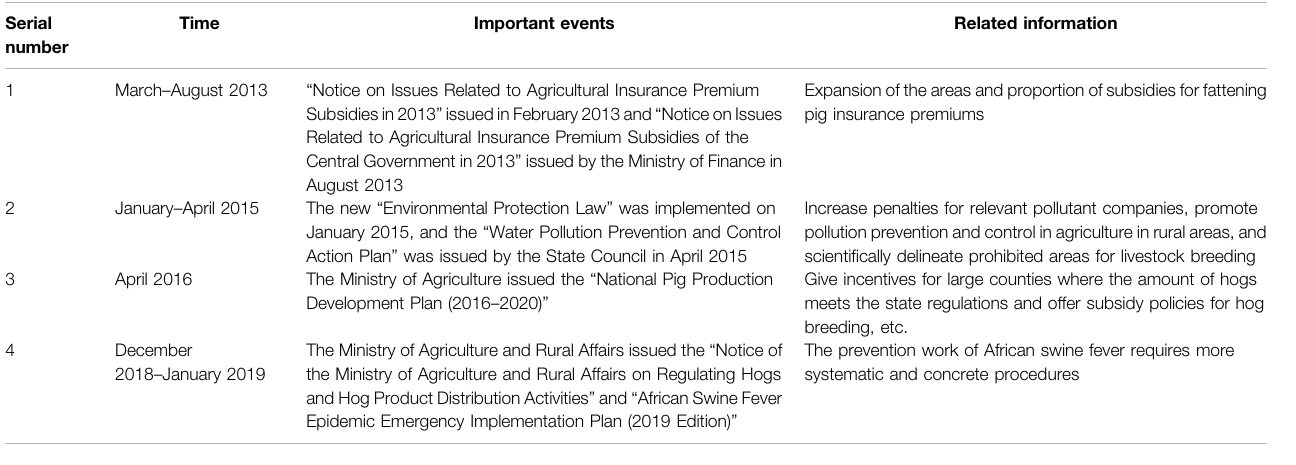
TABLE 5 | List of important regulatory policies affecting the fl uctuation of hog prices.